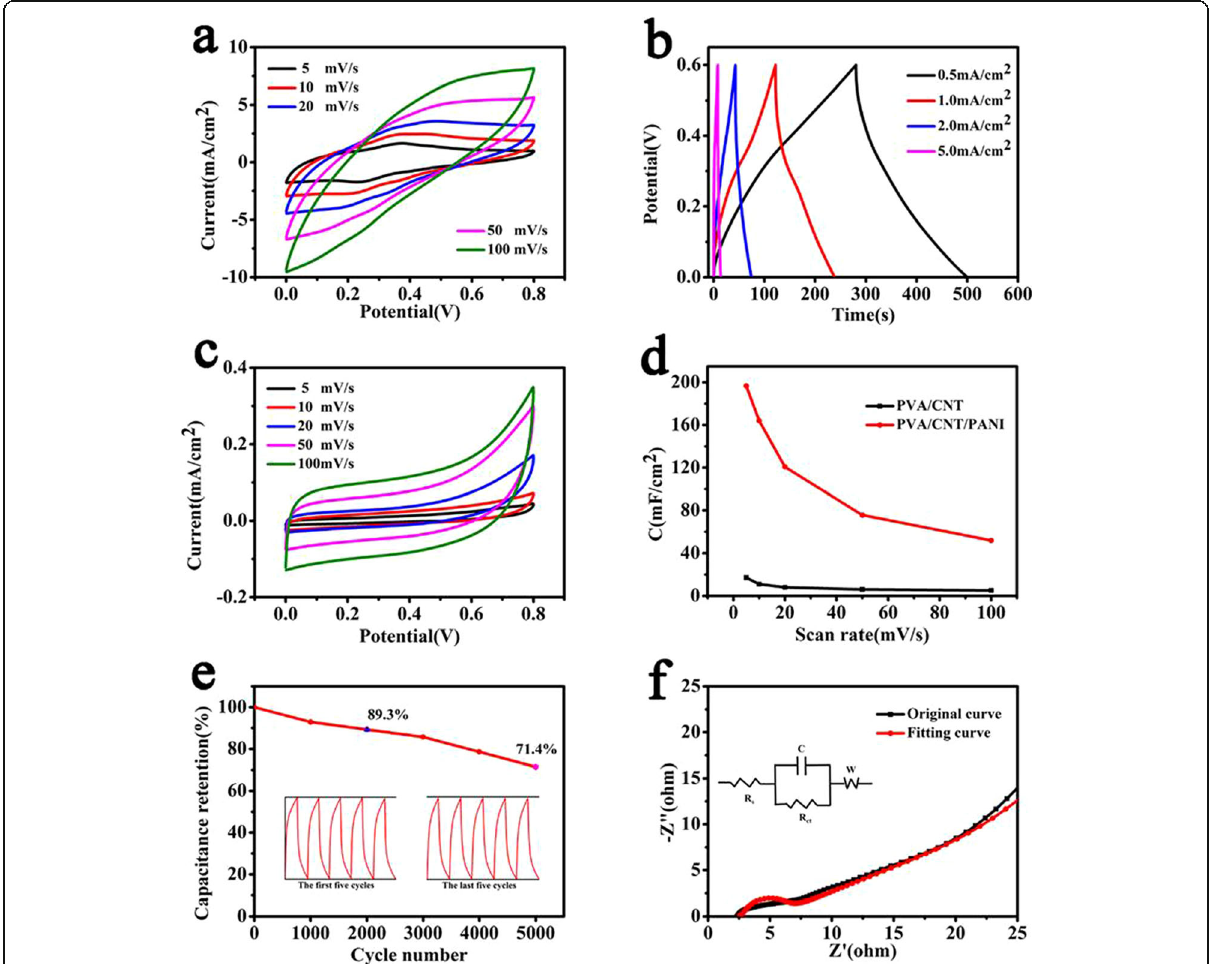
Fig. 6 a The CV curves of the 9 h PVA/CNT/PANI-based supercapacitor and PVA/CNT based supercapacitor ( c ). b Curves of GCD with different current densities of the 9 h PVA/CNT/PANI. d Specific capacitances of PVA/CNT, PVA/CNT/PANI based supercapacitor with increasing scan rate. e Cyclic stability measurement and the insets are cycling curves of the first five cycles and the last five cycles, respectively. f Nyquist plots of the device